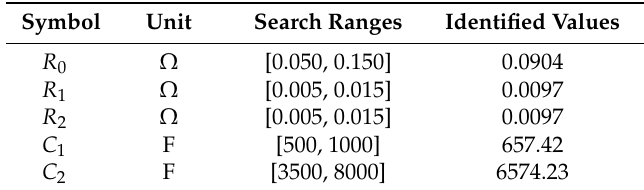
Table 1. The identified parameters for second-order RC ECM of LIB.